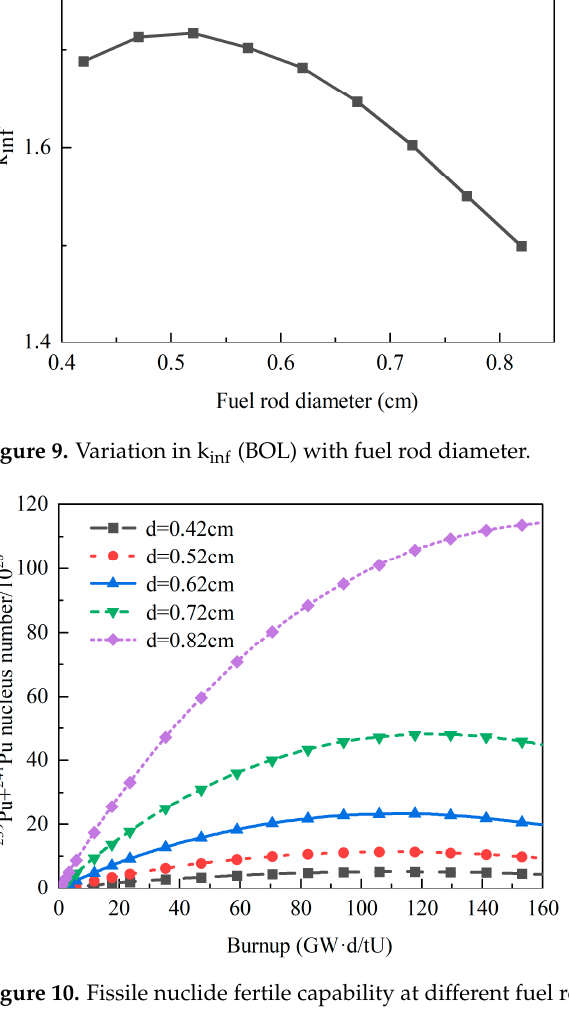
Figure 10. Fissile nuclide fertile capability at different fuel rod diameters.